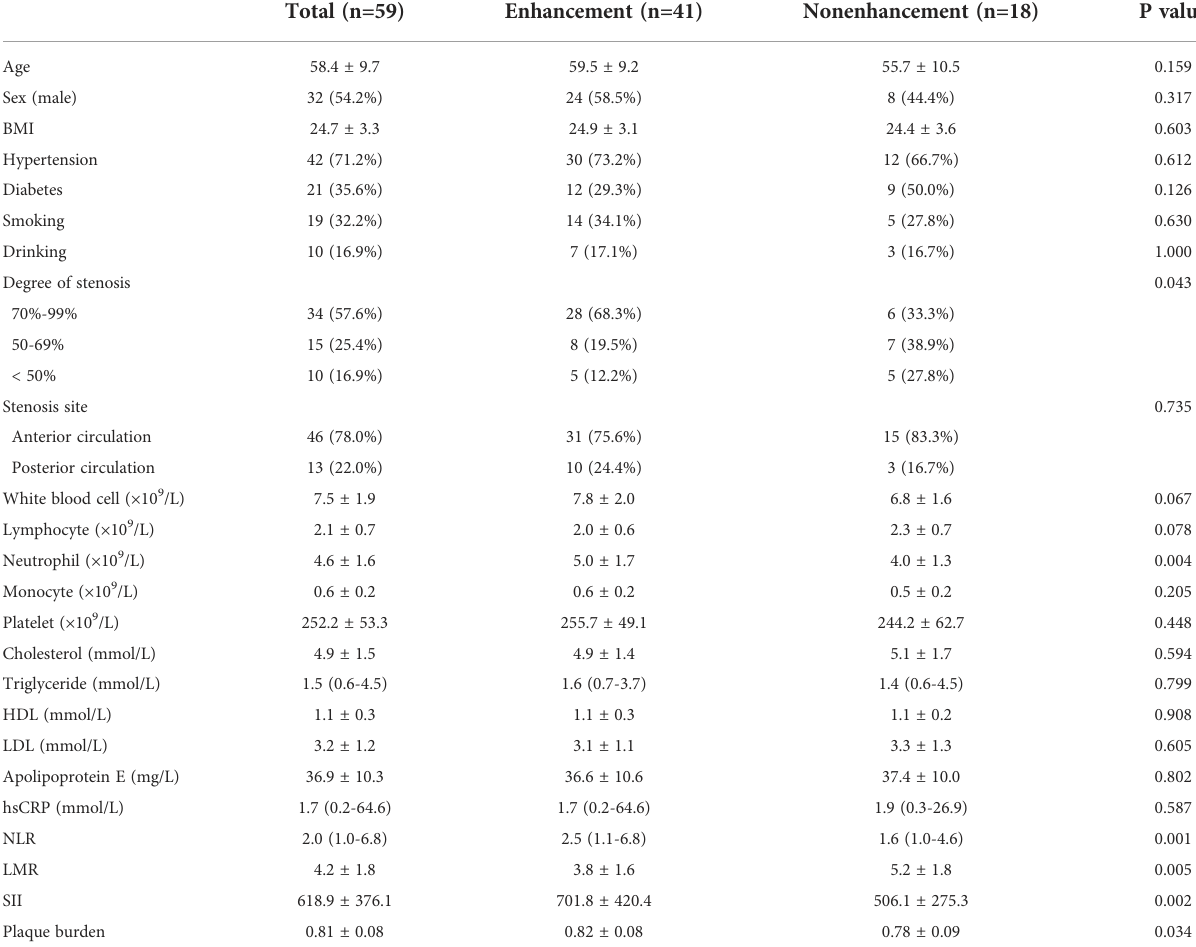
TABLE 1 Characteristics of ICAS atherosclerotic plaques with and without